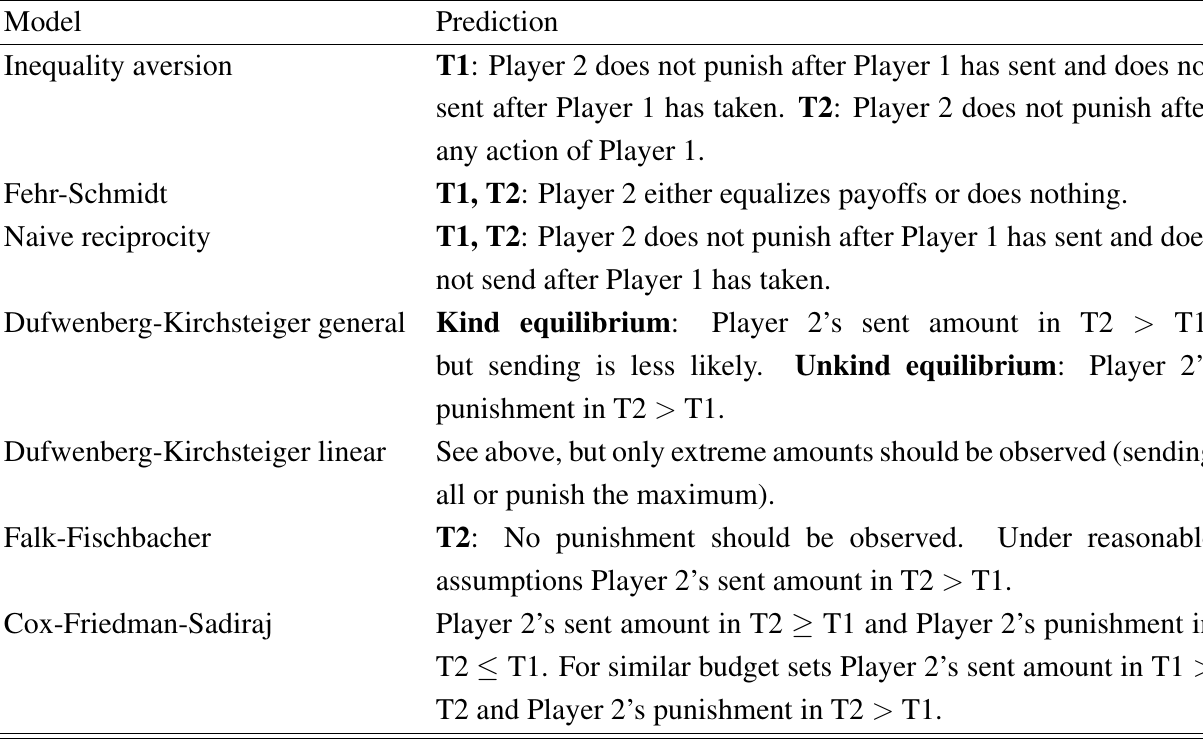
Table 1 . Summary of key predictions by the different